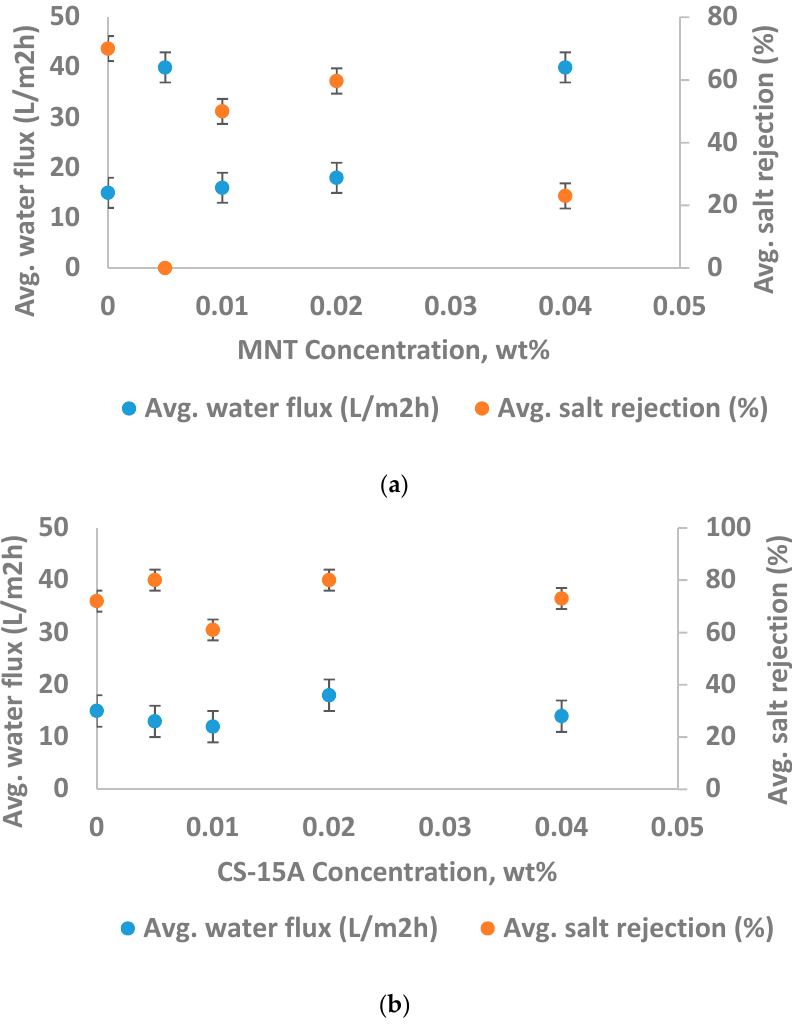
Figure 8. Impact of ( a ) montmorillonite (MNT) concentration and ( b ) cloisite-15A (CS-15A) loading on the performance of the membrane. The test was performed at a pressure of 40 bars, 6 pH, 2000 ppm feed NaCl concentration, and feed temperature of 25 °C.